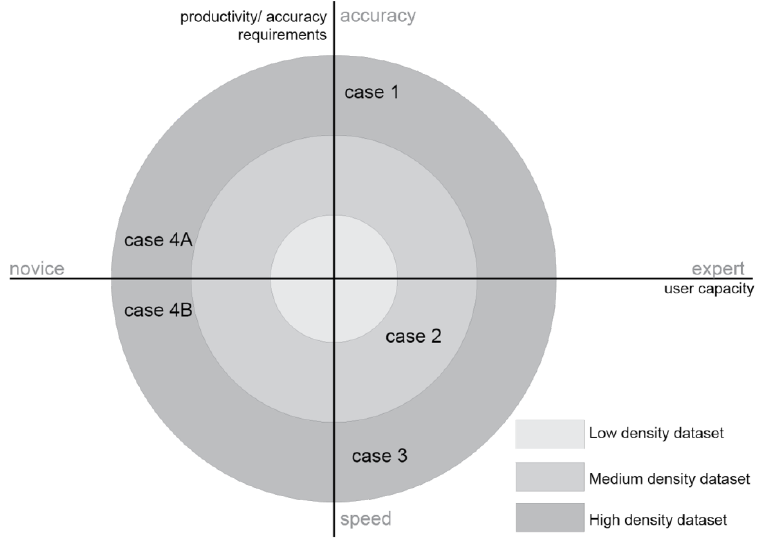
Figure 8: CCLS use case